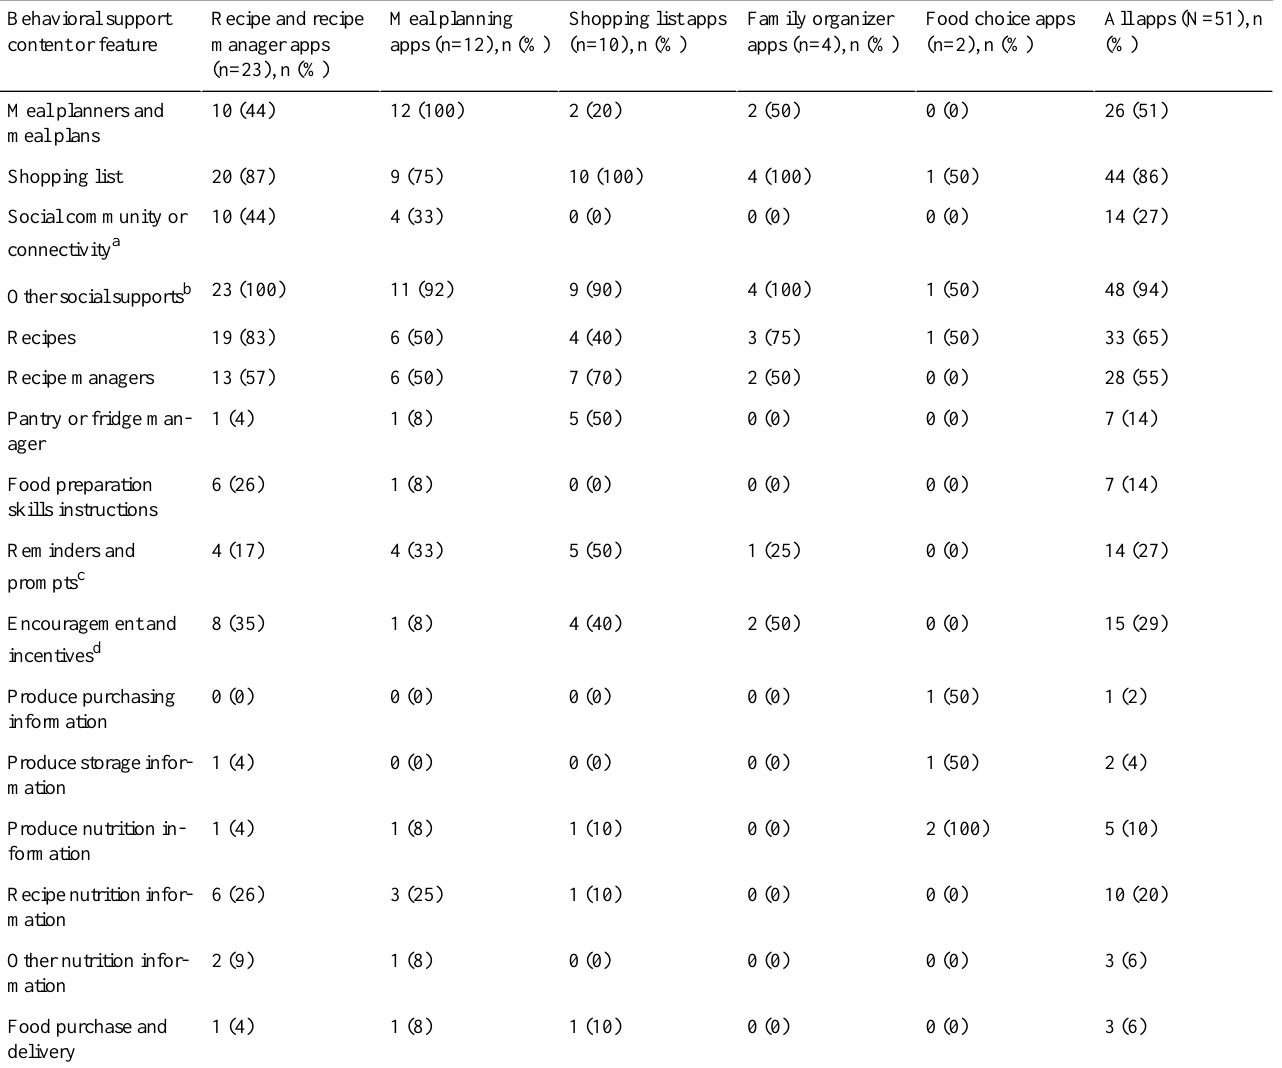
Table 2. App behavioral support content and features presented by app type and across all